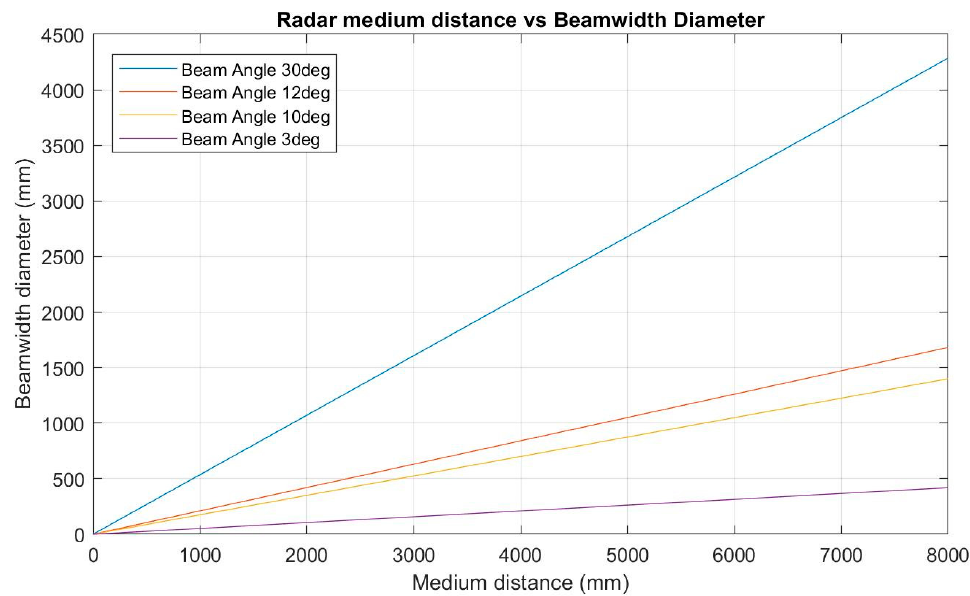
Figure 26. The effect of radar beam angle on the beam width diameter.